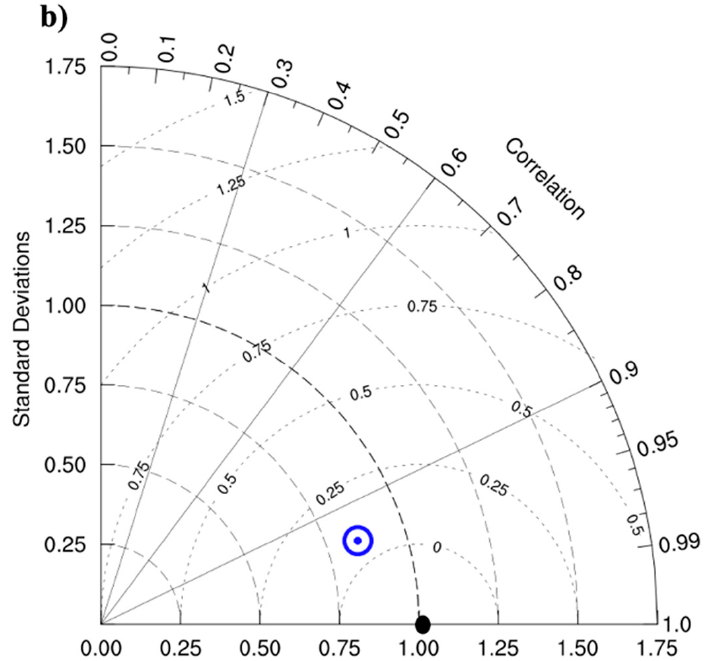
Figure 2. ( a ) Standardized rainfall anomalies showing the interannual variability of rainfall (dark blue bars for the reference data WFDEI and light blue bars for CMIP6 simulations). Boxes indicate the interquartile range and median of the ensemble, whilst the whiskers represent the 5th and 95th percentiles. ( b ) Standardized Taylor diagram displaying the statistics (coefficients, standard deviations and mean square errors) of rainfall comparing multi-model ensemble mean of the bias-corrected CMIP6 with reference climate data (WFDEI). The multi-model ensemble mean of the bias-corrected CMIP6 compared is shown by the blue cycle, and the WFDEI used as a point of reference is shown by the black dot point on the x -axis.